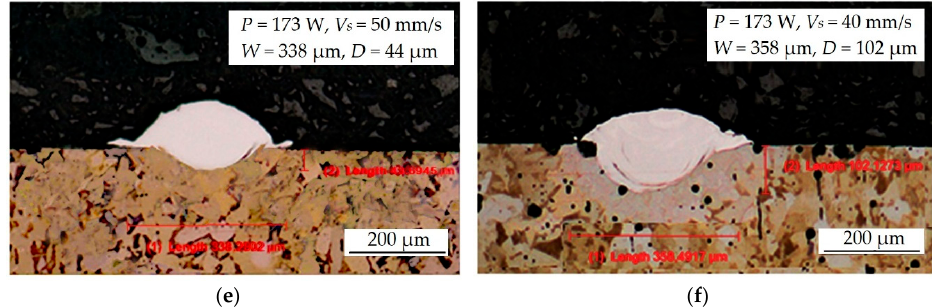
Figure 8. Optical microscopy of the single track cross sections: ( a ) Gaussian in the first process gap; ( b ) flat top in the first process gap; ( c ) donut in the first process gap; ( d ) Gaussian in the second process gap; ( e ) flat top in the second process gap; ( f ) donut in the second process gap. W is the track width; D is the depth.